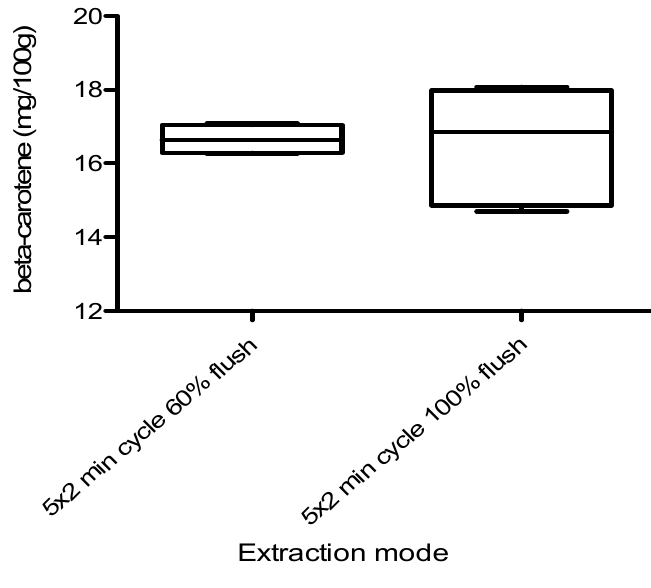
Figure 2. The variation in the yield of carotenoids at different times of extraction and flush per cent. Carrots type I (obtained as fresh), n =